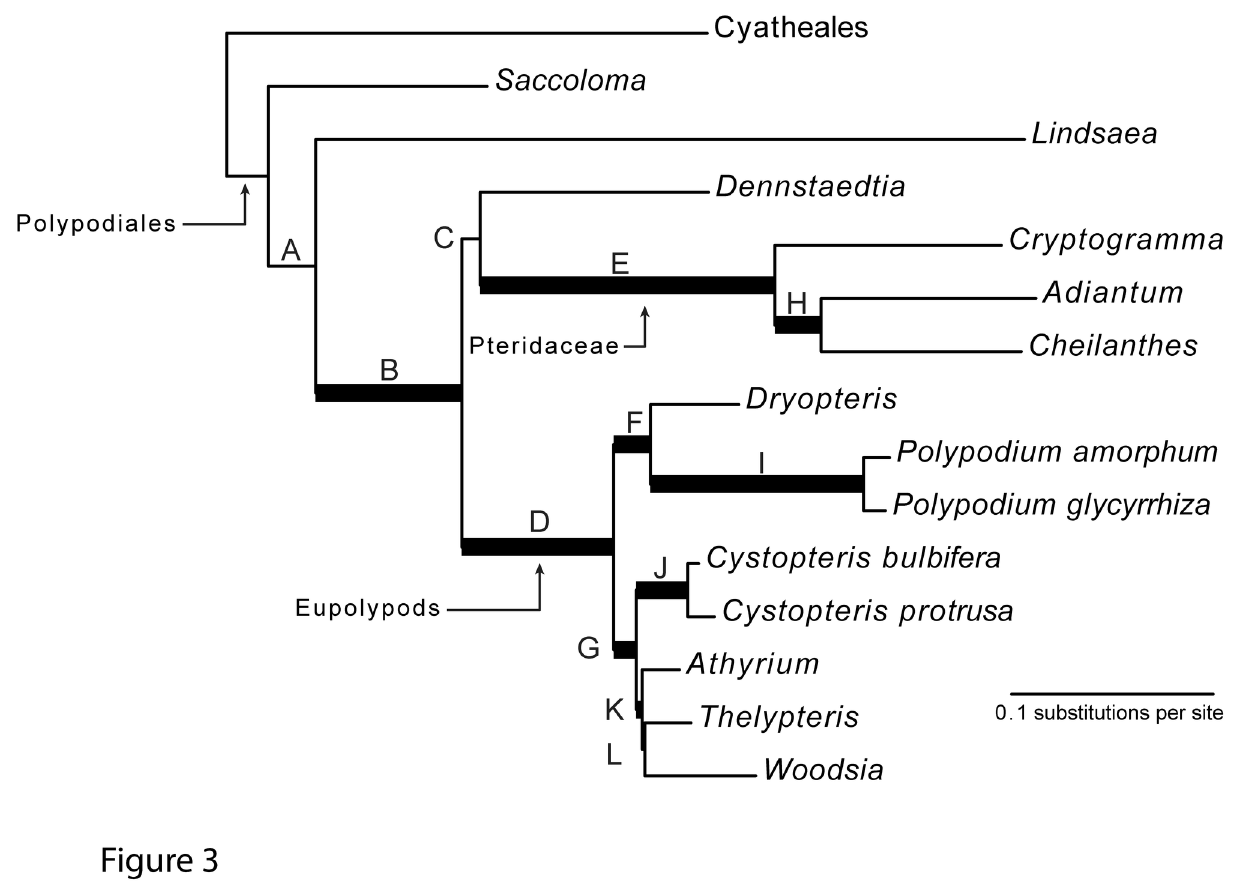
Figure 3. Combined data maximum likelihood phylogram of our 15-taxon genomic DNA test set. Analyses were performed under our best-fitting model (model 3, see Table 3). Bold branches indicate strong support (≥70% bootstrap support); internal branches are labeled A – L for ease of